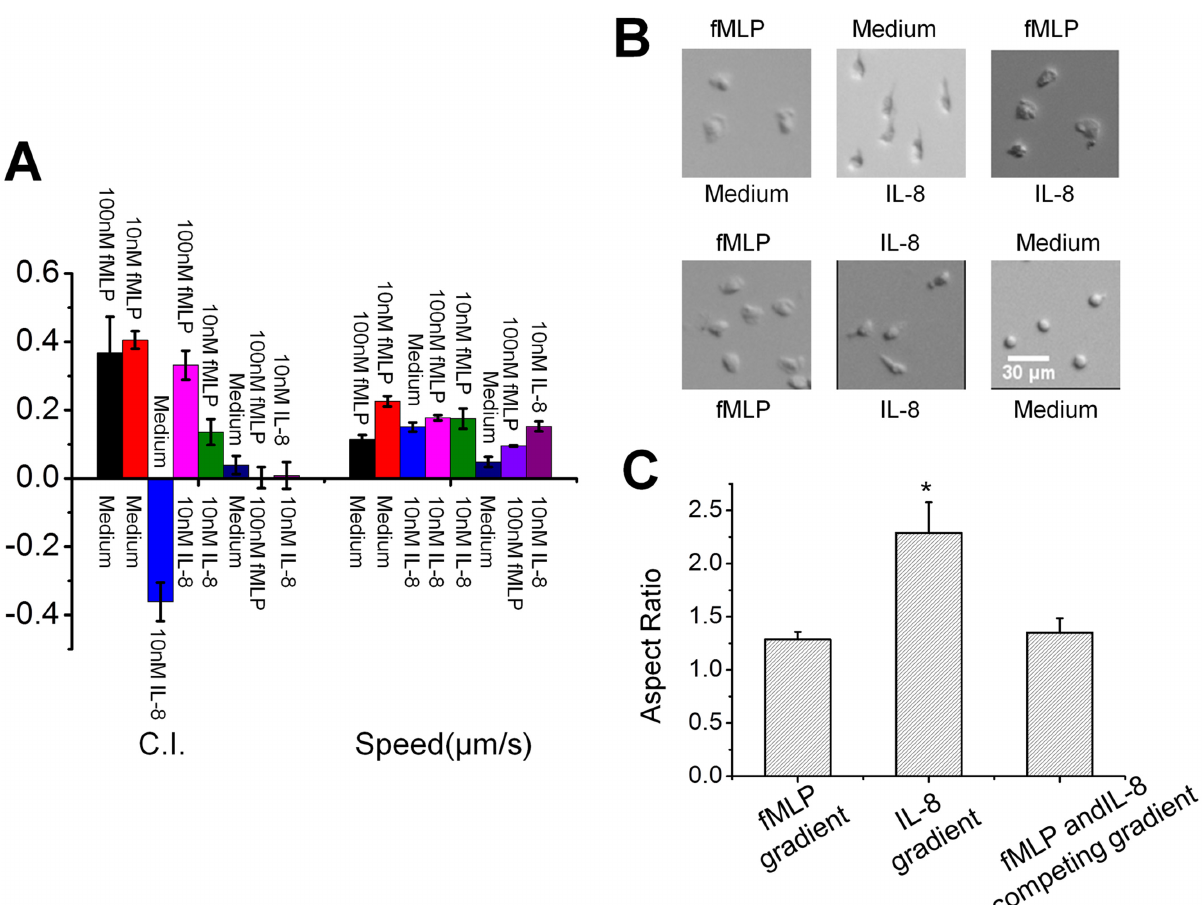
Fig 2. Neutrophil migration in different IL-8 and fMLP fields in the microfluidic device. (A) C.I. and migration speed in different IL-8 and fMLP fields; (B) Representative images of cell morphology in different IL-8 and fMLP fields; (C) Aspect ratio of cells in different IL-8 and fMLP gradients. Positive C.I. indicates cell migration towards the chemoattractant source labeled on the top; negative C.I. indicates cell migration towards the chemoattractant source labeled at the bottom.